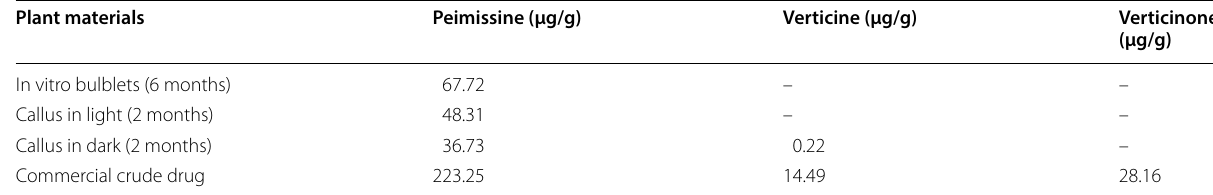
Table 5 LC-MS/MS analysis of peimissine, verticine and verticinone in different plant materials of F. cirrhosa Plant